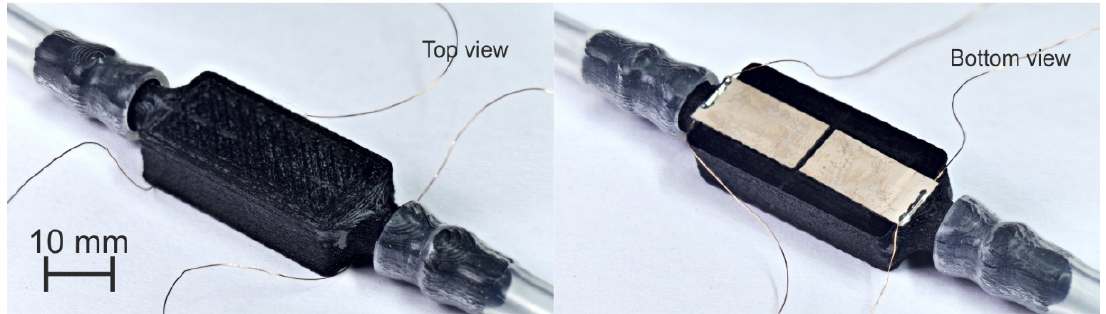
Figure 3. Top and bottom view of the PA-CF fabricated liquid cell. (Wc = 2.5 mm, Tm = 0.5 mm and Lm = 16 mm).